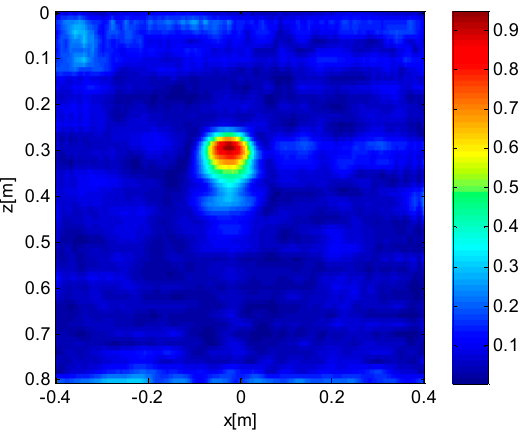
Figure 2. Target reconstruction with an observation domain equal to 0.8 m.